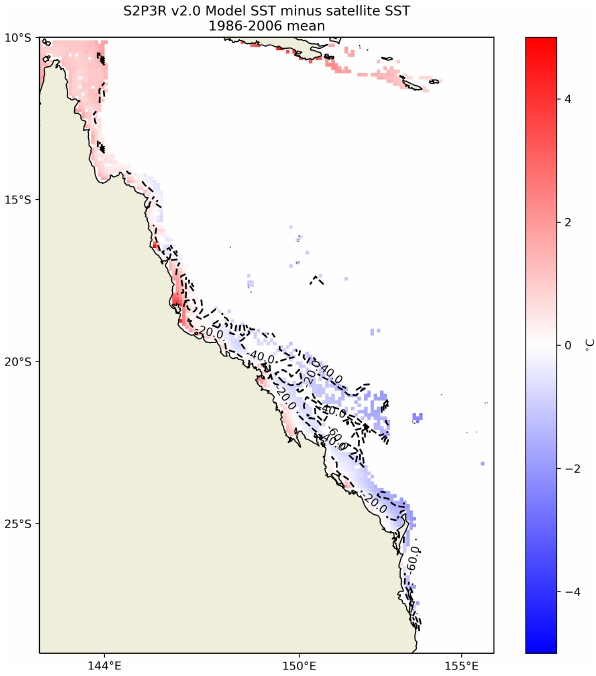
Figure 15. S2P3R v2.0 SST averaged between 1986 and 2006 in- clusive minus satellite SSTs (Merchant et al., 2019) over the same interval. Labelled dashed lines show bathymetry in